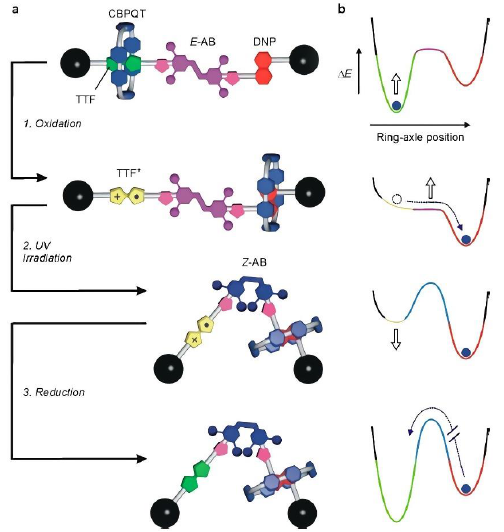
Figure 1. Schematic representation of the redox and photochemically triggered switching processes in rotaxane 1 4+ . ( a ) Initially, the CBPQT ring encircles the TTF site on account of stronger π -electron donor–acceptor interactions than with the DNP site. Oxidation of the TTF site while the azobenzene unit (AB) is in the E configuration (process 1) is followed by the fast translation of the ring to the DNP site by Brownian motion. Irradiation of the oxidized rotaxane at 365 nm causes the isomerization of the azobenzene unit to the bulkier Z configuration (process 2) without affecting the position of the ring along the axle. Upon regeneration of the TTF primary station by reduction (process 3), a driving force for the return of CBPQT on the TTF site is created; however, because of the presence of the Z -AB stopper, the ring remains blocked in a nonequilibrium state. Therefore, as shown by the simplified potential energy curves ( b ), the macrocycle is moved energetically uphill by an energy ratchet mechanism. Reproduced with the permission of the American Chemical Society from [42]. Copyright 2019, American Chemical Society.